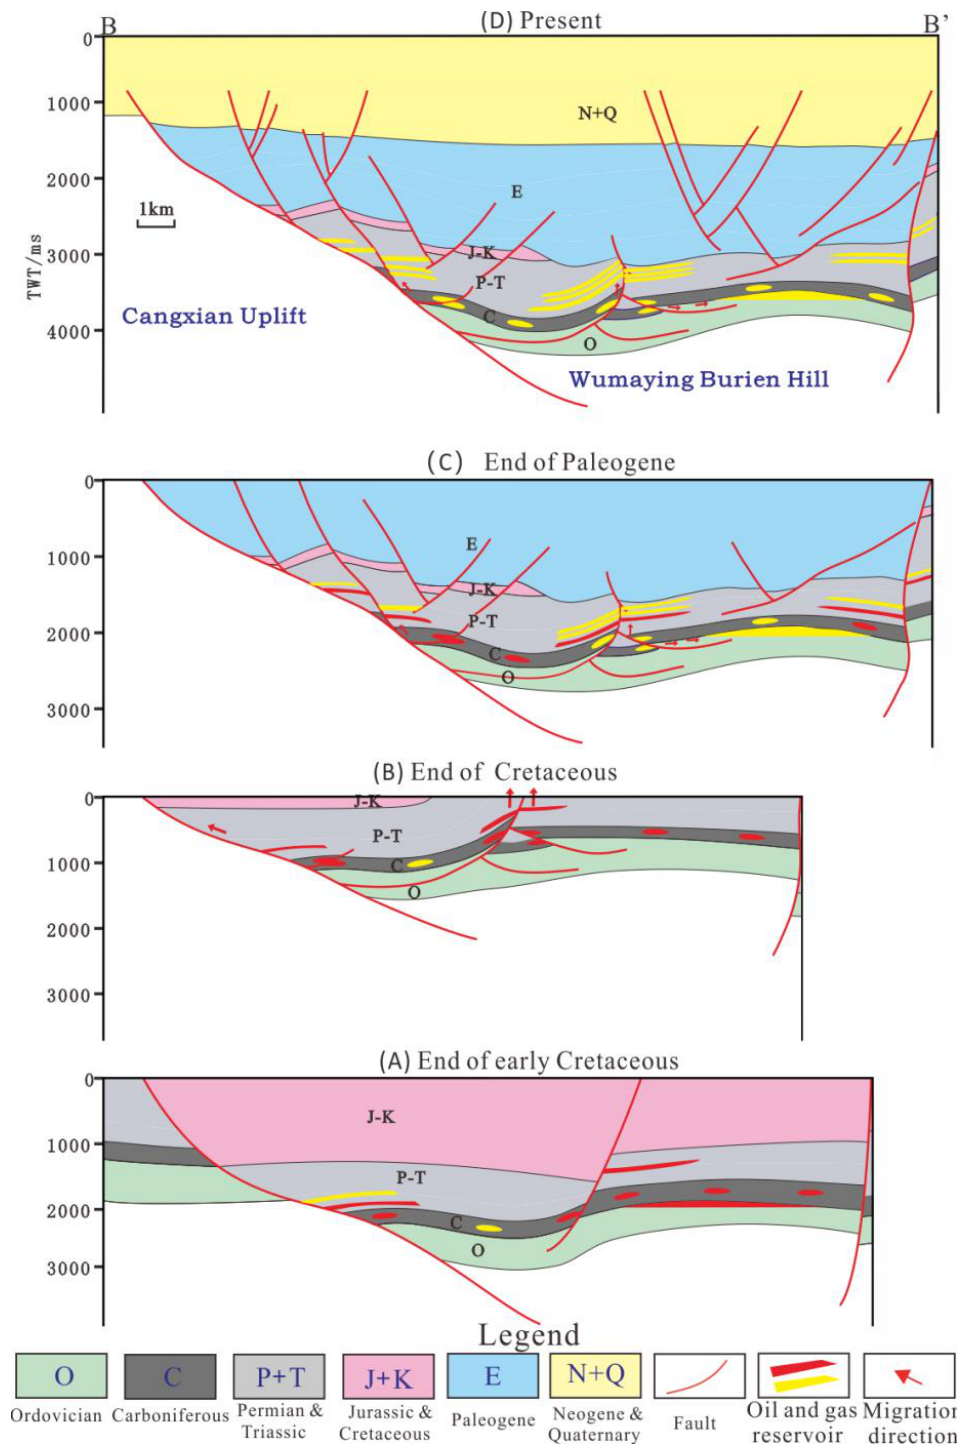
Figure 13. Hydrocarbon accumulation process of Permian reservoir in the Wumaying buried hill (refer to Figure 1 for locations of the profiles).